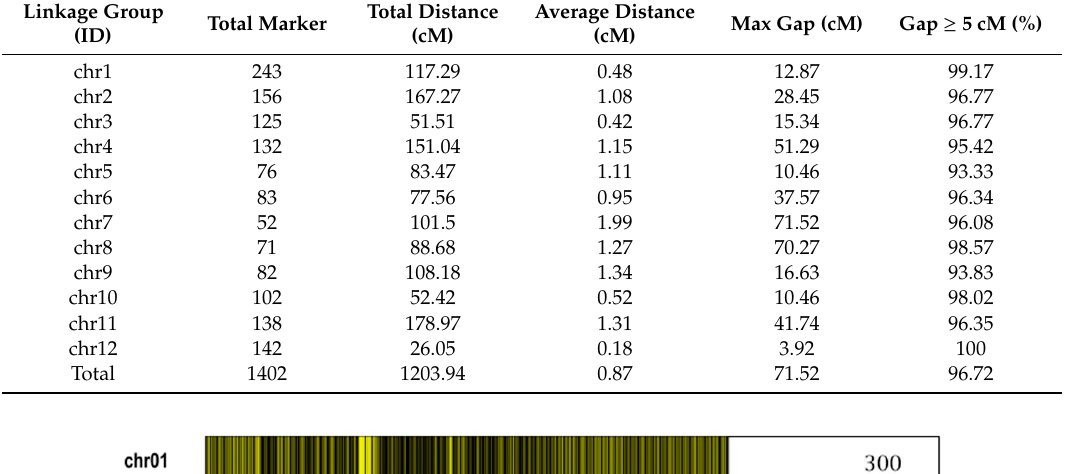
Table A2. The paternal genetic map for tetraploid potato.